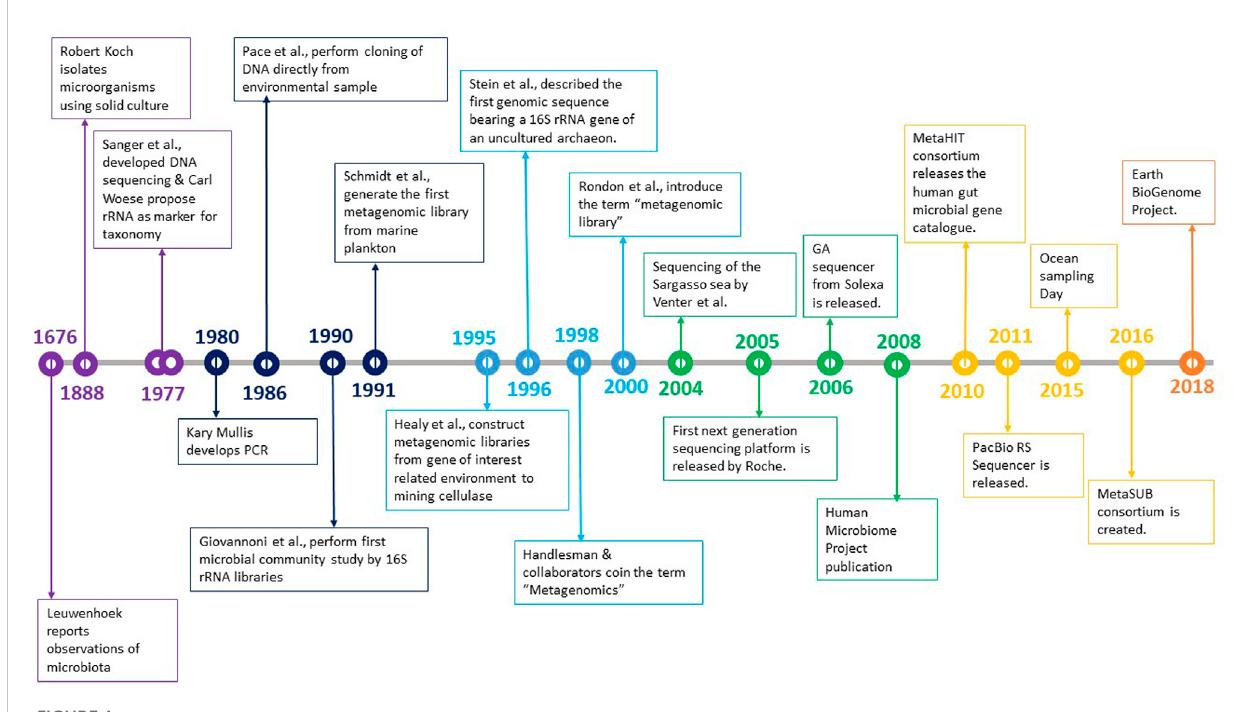
FIGURE 1 Development in the fi eld of microbiology over the